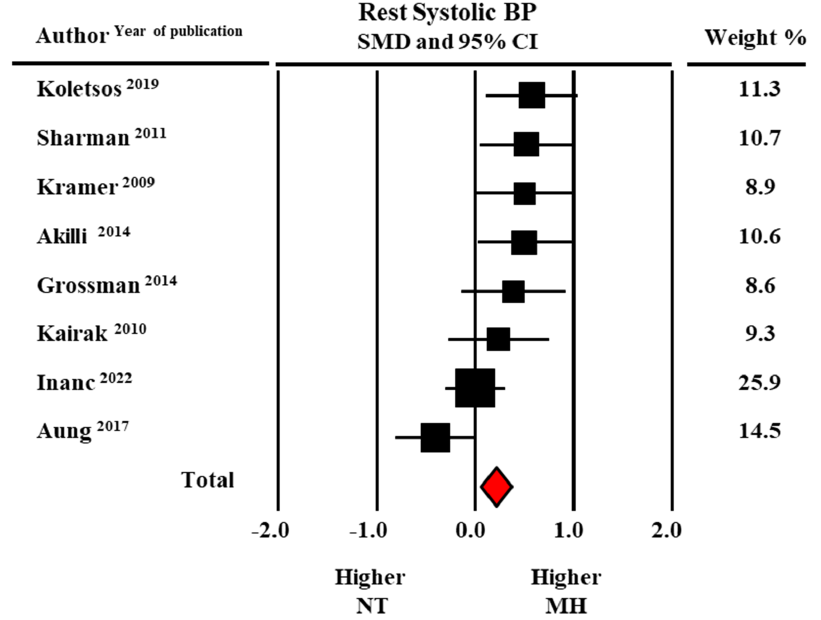
Figure 2. Forest plot of systolic blood pressure (BP) at rest in masked hypertensive (MH) and normotensive (NT) individuals. Standard mean difference (SMD) and 95% confidence interval (CI). Fixed model [21–27,29].